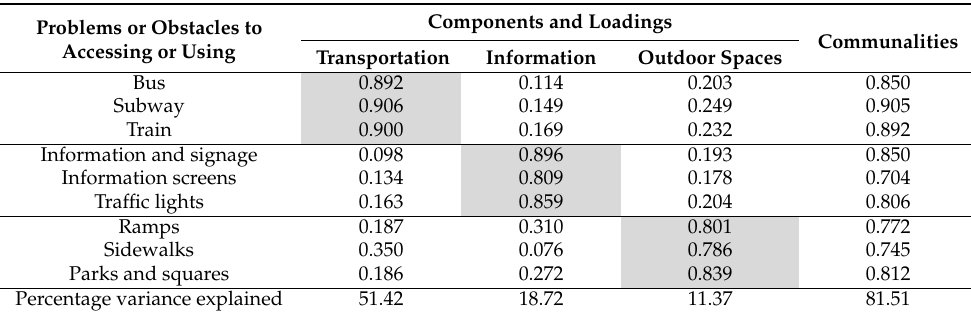
Table 2. Principal component analysis for urban environmental